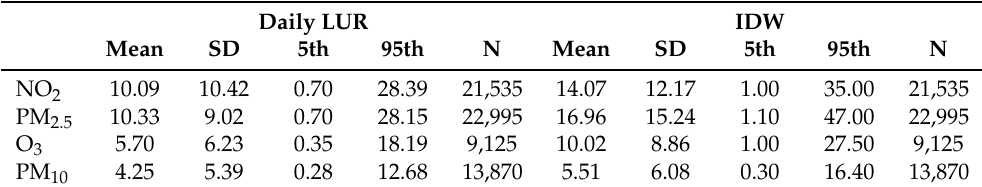
Table 1. Summary statistics describing the absolute difference, in µgm − 3 , between the average daily pollution observed at the monitoring site and average daily pollution concentrations at the same site estimated through (a) daily LUR or (b) IDW ( | Deviation m , d | ). Pollution concentrations are across four pollutants: O 3 , NO 2 , PM 2.5 , and PM 10 . Daily LUR IDW